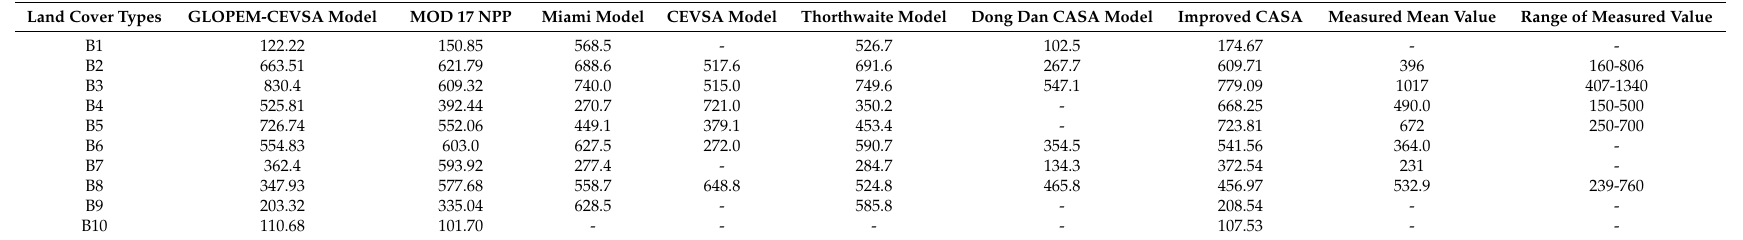
Table 5. Comparison of vegetation NPP results from different models (gC m 2 · a − 1